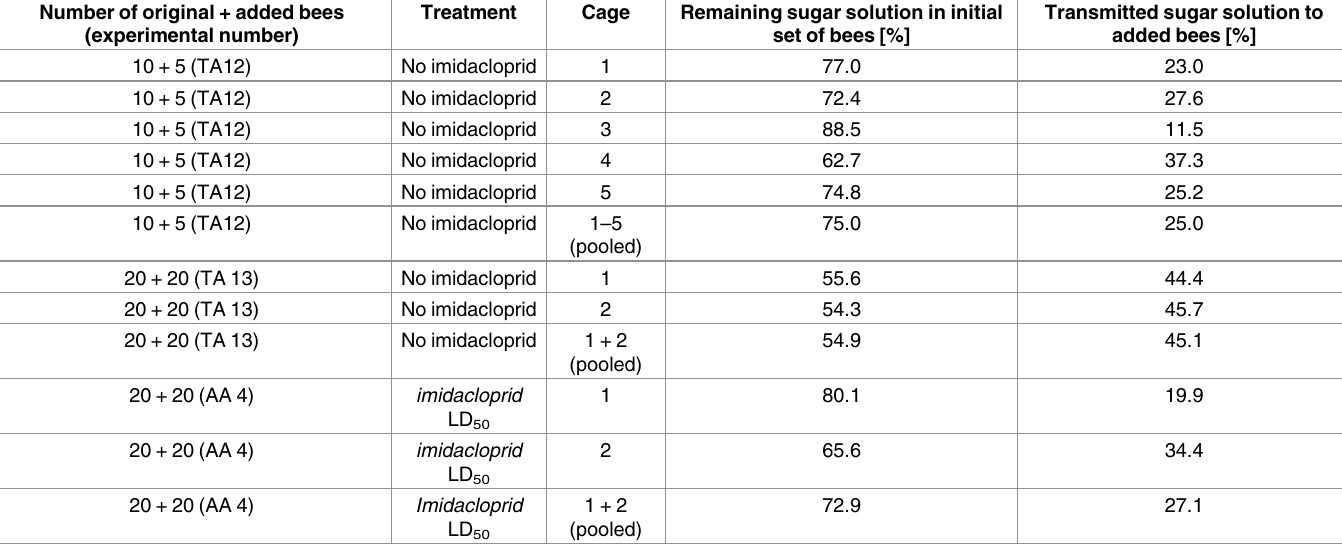
Table 5. Food circulation among initially fed bees and added bees. Remaining and transmitted 14 C-labelled sugar solutionfor individualcages and pooledper replicatefor temporary (TA12 and TA13) and acute (AA4) feedingregimes with and without imidacloprid. Number of original + added bees (experimental number)